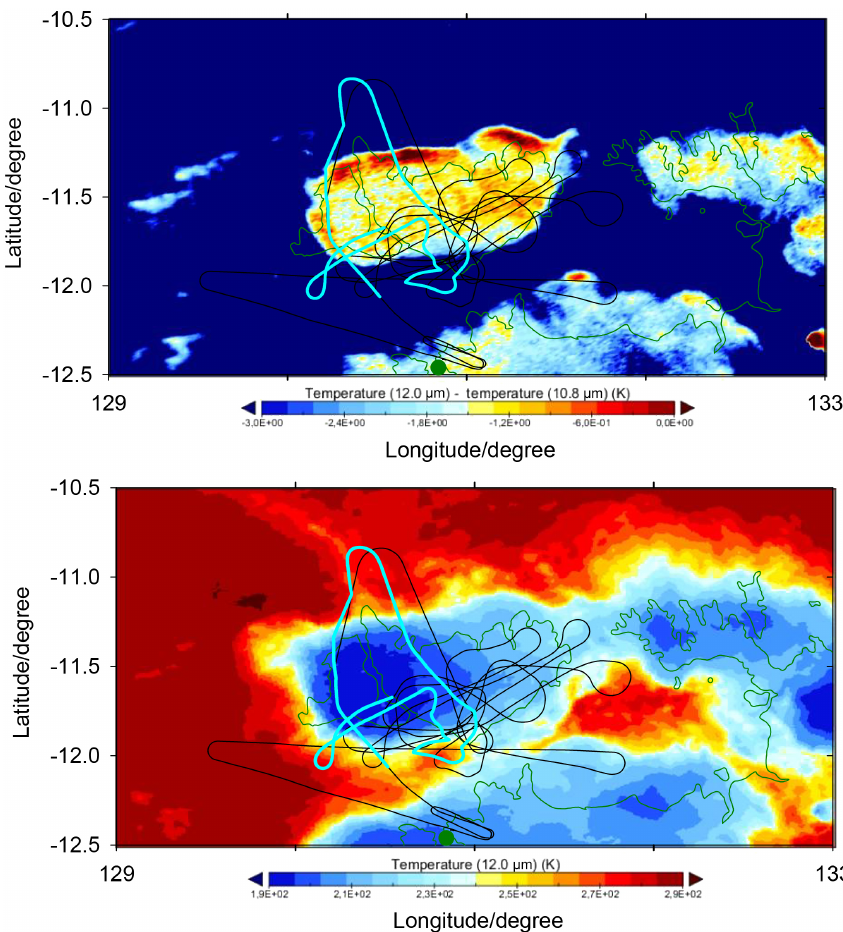
Figure 14. Brightness temperature (BT; bottom, at 10.8µm wavelength) and BT difference (BTD; top; difference between BT at 10.8 and 12µm) from 1km resolution NOAA-12 AVHRR at 07:43:20UTC 30 November 2005. The black curve is the Geophysica flight path. A white line depicts the Falcon flight path during Hector anvil lidar observations between 07:35 and 07:41UTC. The cyan curve is the computed position of the contrail for ages <2.7h at the time of the overpass. Green symbol/line: Darwin and the coast